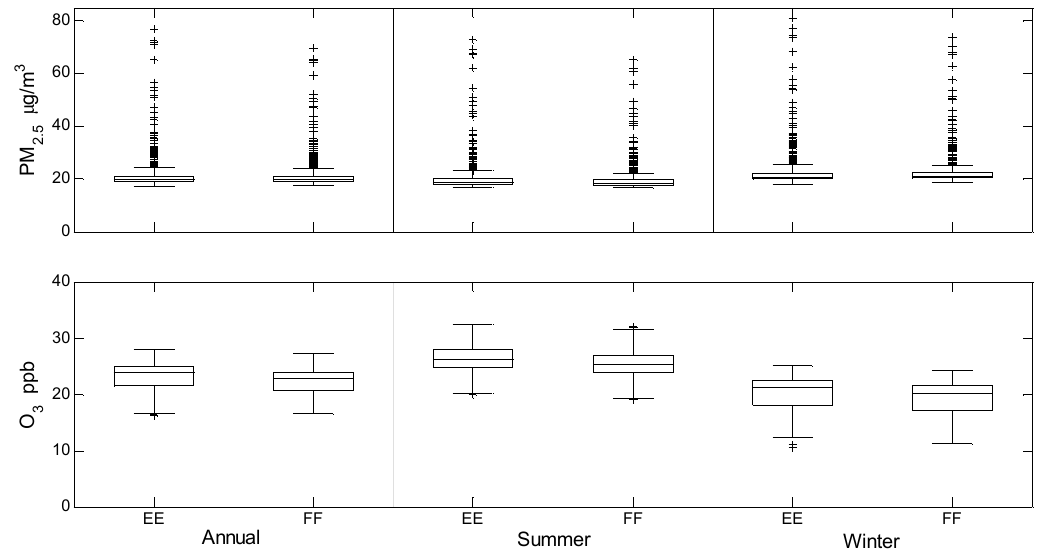
Figure 2. Boxplots summarizing annual, warm and cold season concentrations of fine particulate matter (PM 2.5 ) and ozone (O 3 ) in the 645 municipalities of São Paulo State in the Ethanol Expansion (EE) and Fossil Fuel (FF) scenarios.